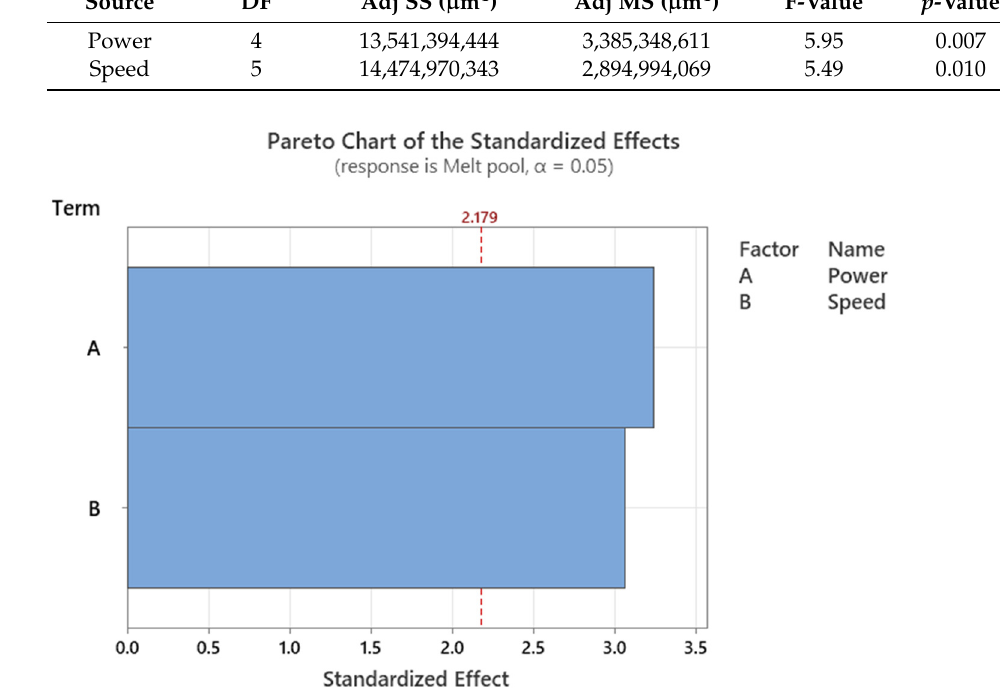
Figure 9. Pareto chart of the standardized effect of laser power and scan speed on melt pool .